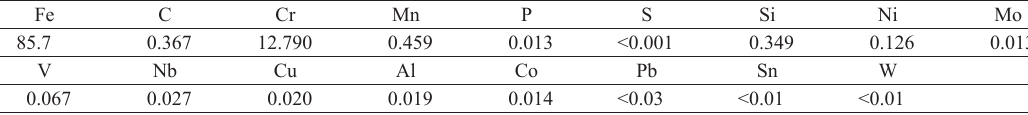
Table 1. Chemical composition of the purchased AISI 420 (in wt%).